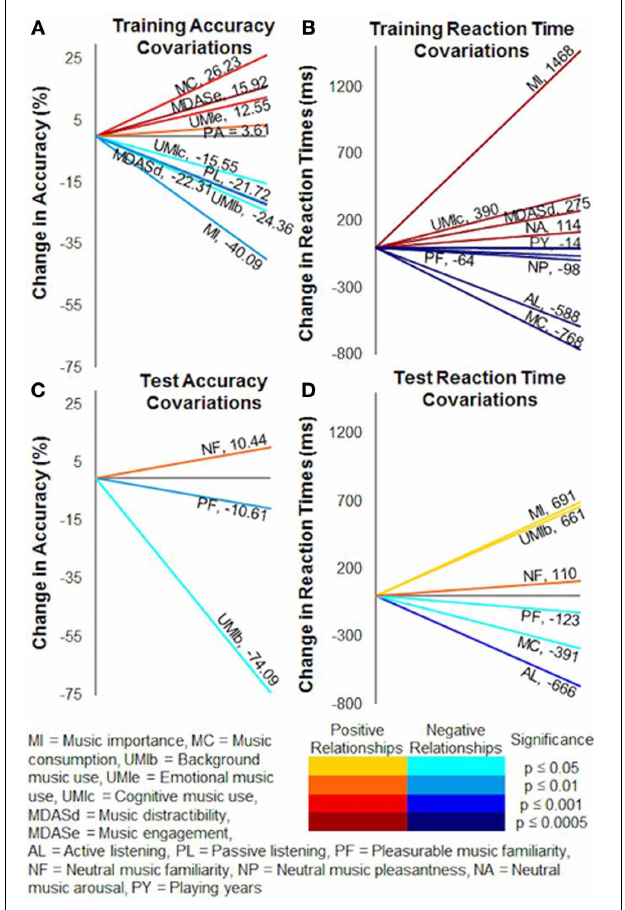
FIGURE 8 | Covariate relationships on training and test accuracy and reaction times. Factors from the Helsinki Inventory of Music and Affective Behaviors (HIMAB) and the listening test significantly covaried with probabilistic selection task performance. (A) Training accuracy. (B) Training reaction times. (C) Test accuracy. (D) Test reaction times. Numerical values show the slopes of the covariations, and colors represent the directions and significance levels of the